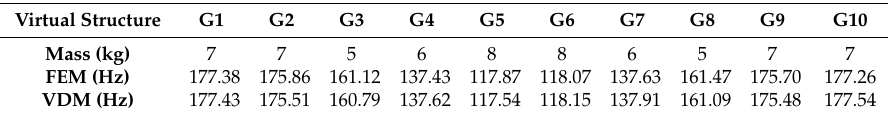
Table 5. Frequency comparison of ten virtual structures.